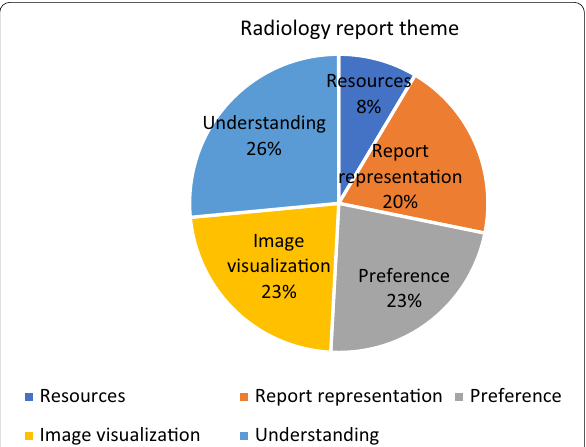
Fig. 4 Percentage of questions of sub-themes among in